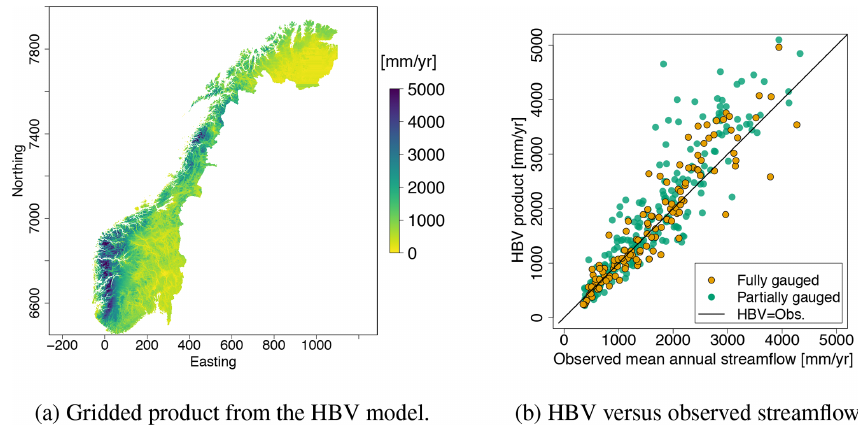
Figure 2. A mean annual runoff (1981–2010) product simulated by the HBV model (a) . The product is delivered on a 1 × 1km grid. (b) The fit between the HBV product and the actually observed streamflow for the fully gauged (orange) and partially gauged catchments